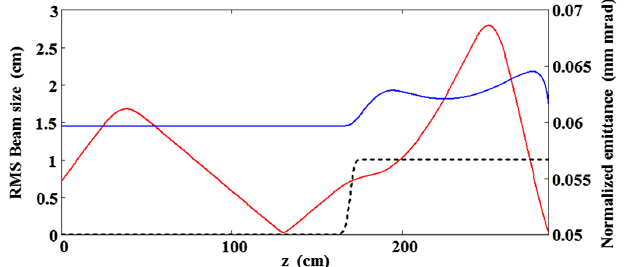
12. Simulation results from VACO of an example with a high perveance beam ( 4 . 1 × 10 − 3 ) — the initial particle distribu- tion is UG. Red: rms beam size; dashed black: neutralization profile ( 0 ≡ neutralized, 1 ≡ full beam current); blue: emittance evolution